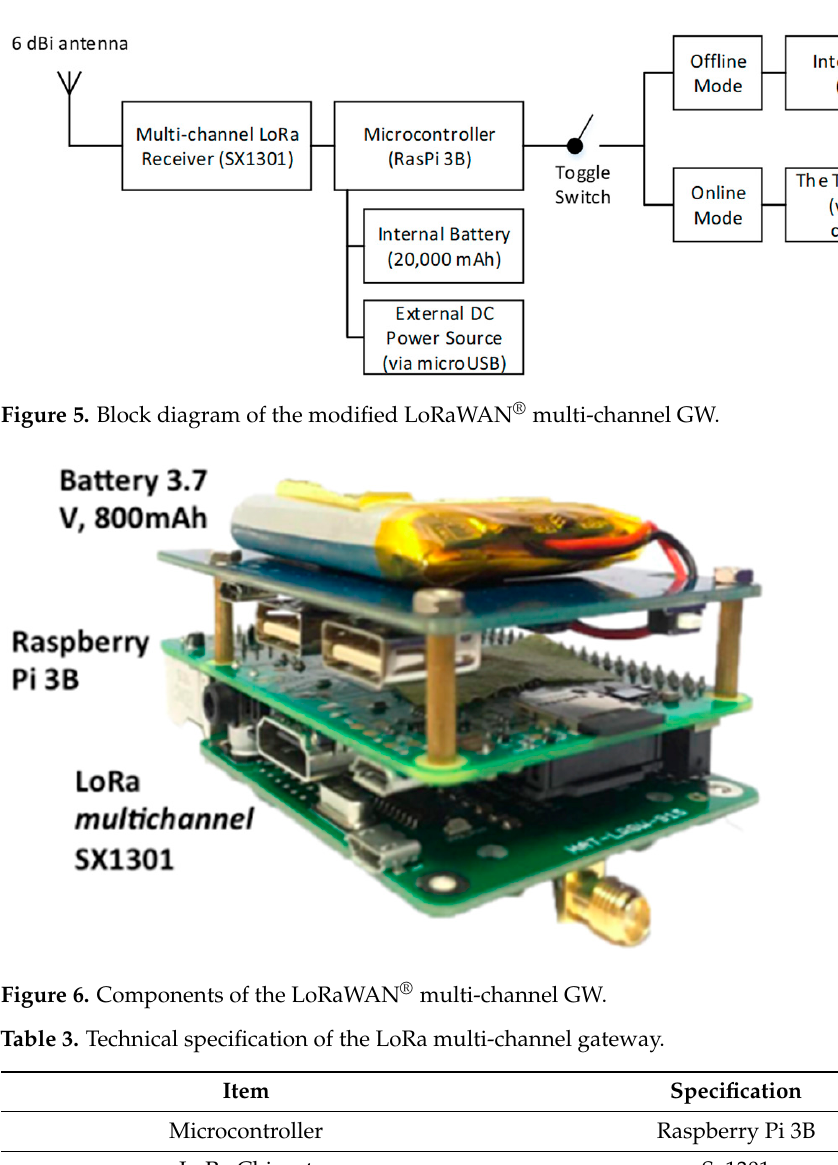
Table 3. Technical specification of the LoRa multi-channel gateway.